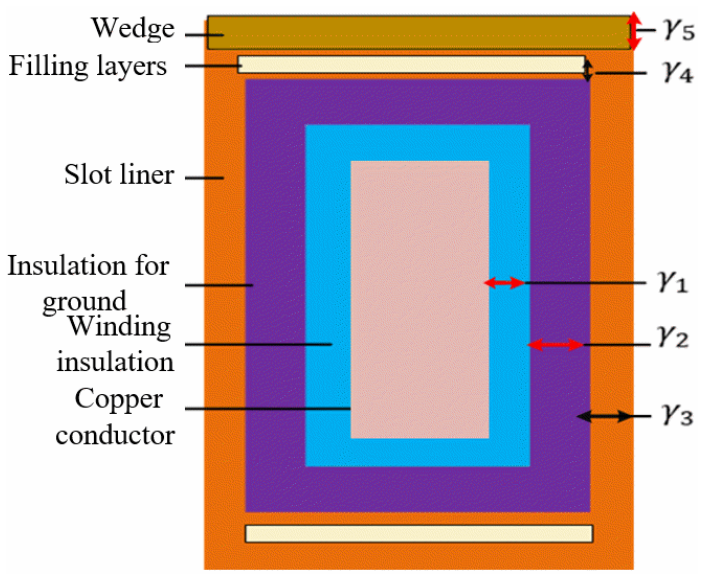
Figure 10. Slot winding equivalent structural